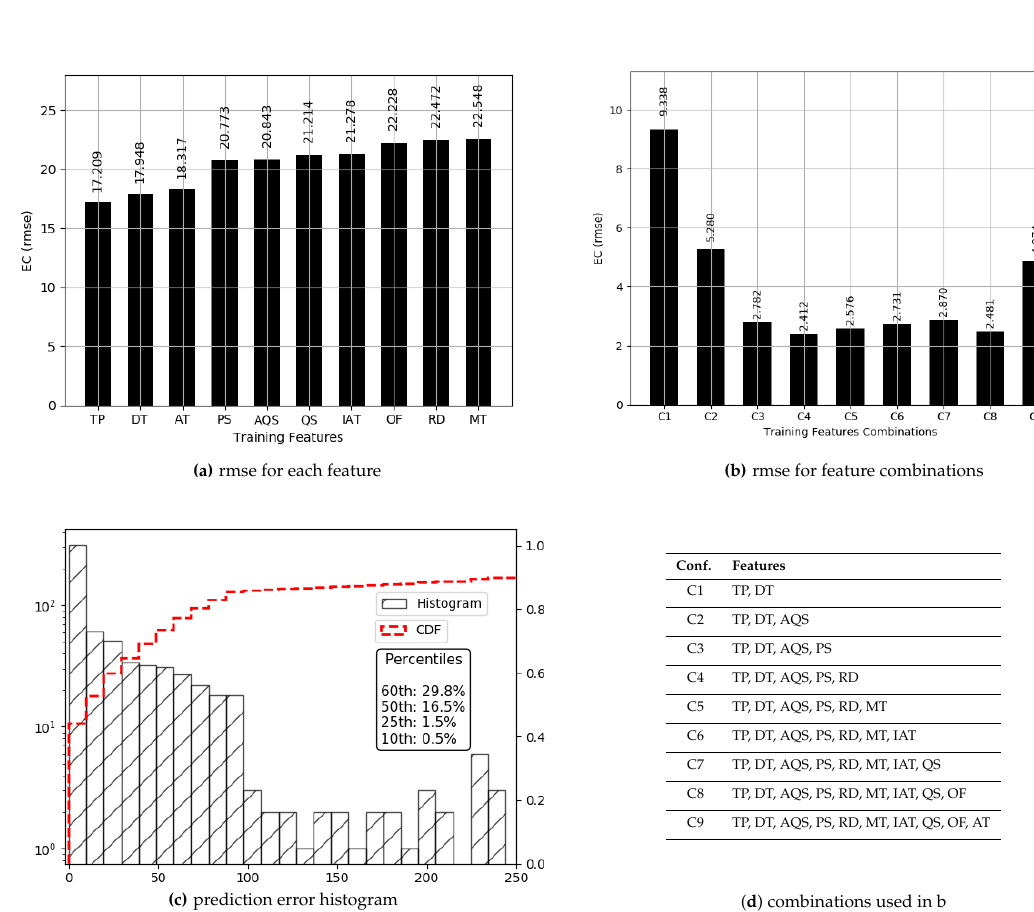
Figure 12. Prediction results for EC sparse